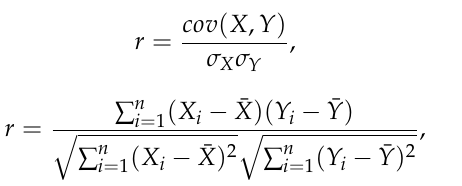
(mm 2 ). In order to analyze the result, a histogram of the residual result points is marked as shown in Figure